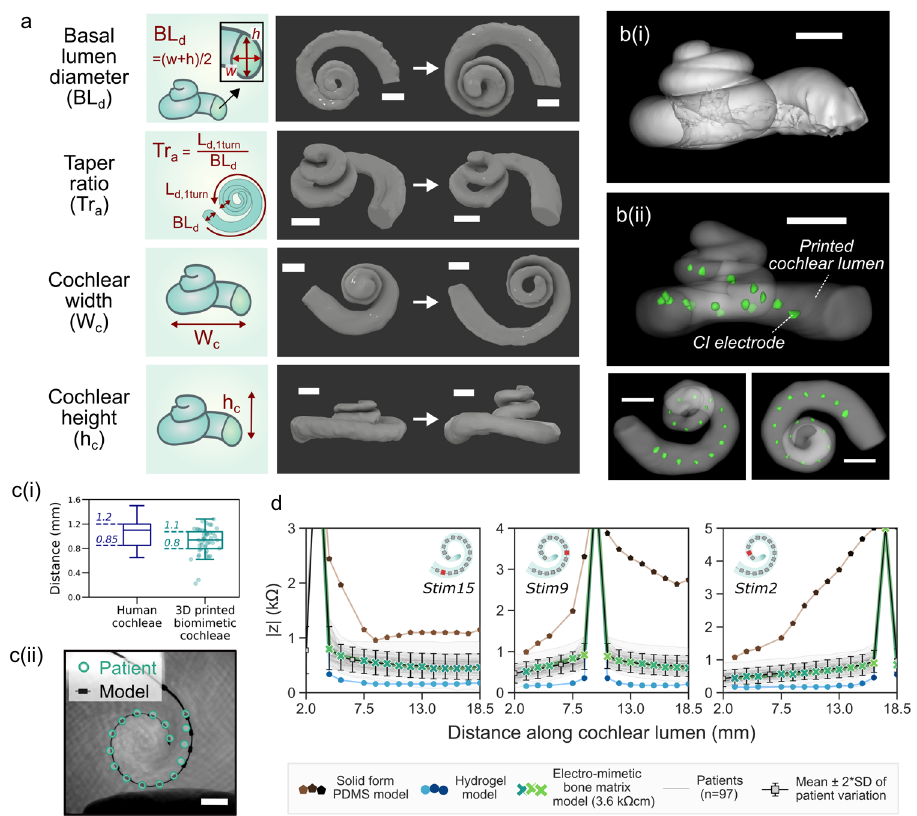
Fig. 4 3D printed biomimetic cochleae replicate the broad anatomical spectrum of human cochleae, enable geometrically-guided CI positioning and give patient-relevant EFI pro fi les. a µ -CT reconstructed images of the spiral lumen of the biomimetic cochlea with different geometric features. Scale bar = 2 mm. Four geometric descriptors are used — basal lumen diameter, taper ratio, cochlear width and cochlear height. Detailed de fi nitions and the range of the descriptors tested in this study can be found in Supplementary Table 1. b µ -CT reconstructed images of (i) a cadaveric cochlea and (ii) the lumen of an exemplar 3D printed biomimetic cochlea with CI electrode array (marked green) implanted. Scale bar = 2 mm. c (i) The electrode-to-spiral centre distance ( n = 48) of the biomimetic cochleae, compared to the electrode-to-modiolus distance of human cochleae with the same CI electrode type implanted (HiFocus TM 1 J electrode array), replotted from literature 31 . c (ii) Example showing overlapped CT and x-ray images of the CI electrode positions in a patient ’ s cochlea and in a biomimetic cochlea that has similar geometric descriptors to the patient ( n = 3, Supplementary Fig. 7b). Scale bar = 2 mm. d Comparison of the mean patient EFI pro fi le ( n = 97), and the EFI pro fi les obtained from 3D printed models made of hydrogel, solid PDMS and electro- mimetic bone matrix (3.6 k Ω cm). The mean patient EFI was derived from 97 clinical EFIs that are not paired with CT information (with 91 independently acquired by Advanced Bionics ® and six acquired by CI 1J from our own repository), on the assumption that the insertion depths follow the suggested insertion depth of CI 1J . EFIs induced by the stimulations of the basal electrode (electrode 15), the medial electrode (electrode 9) and the apical electrode (electrode 2) were